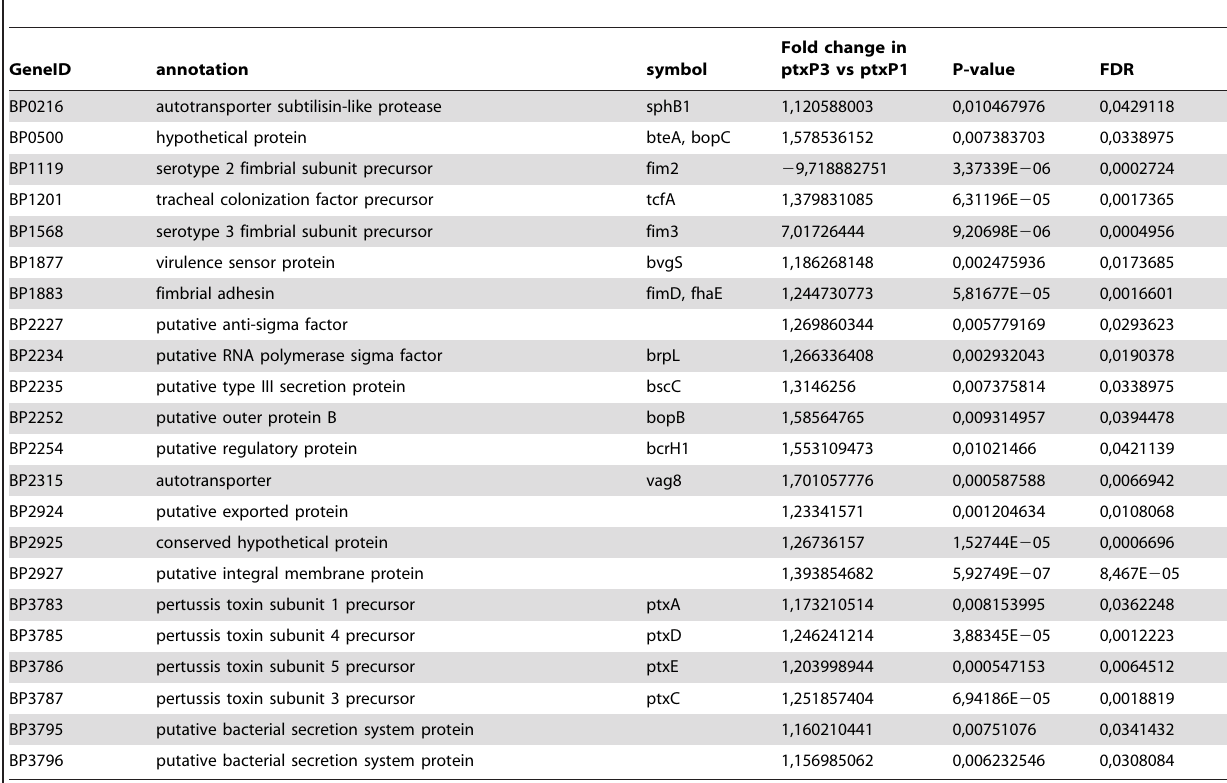
Table 2. Genes from the vir-core regulon were significantly upregulated in the ptxP3 strains compared to the ptxP1 strains.